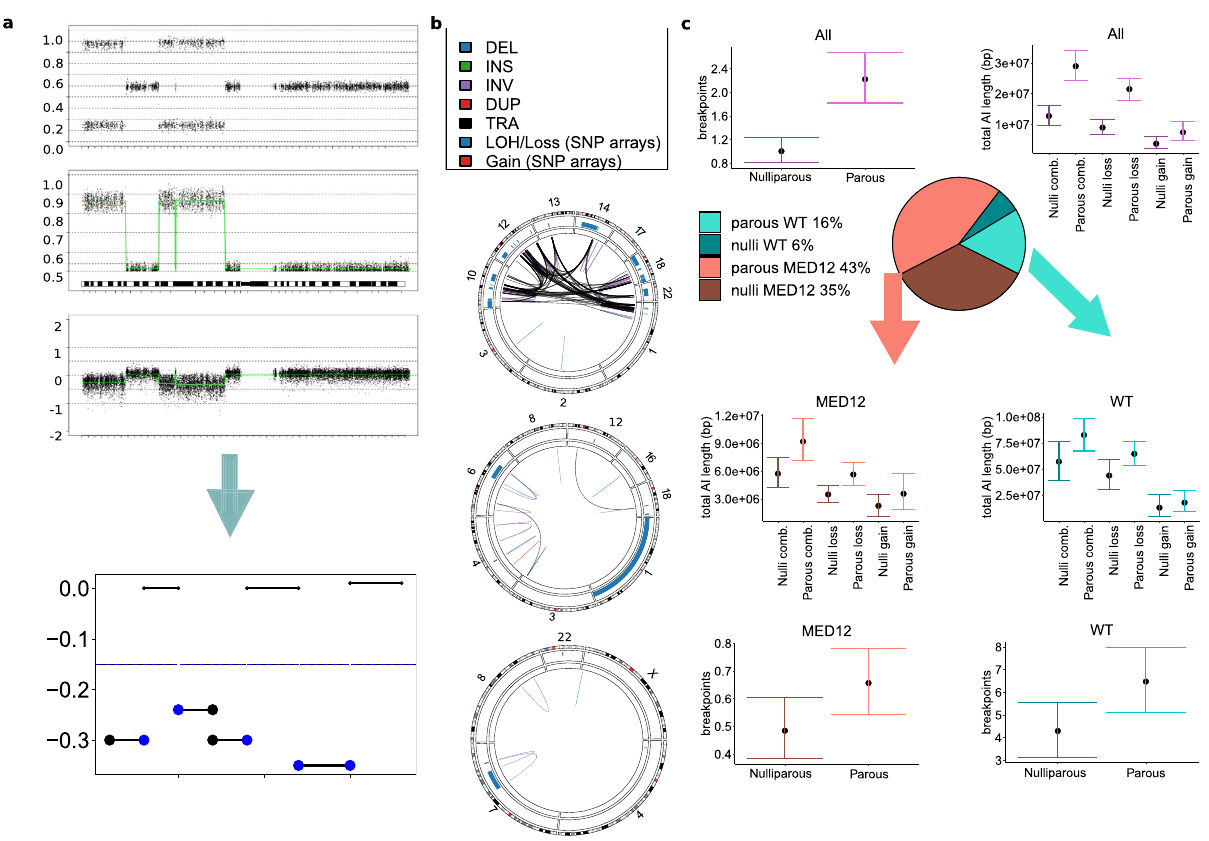
Fig. 2 Overview tumor characteristics. a Allelic imbalance (AI) segments in SNP-array data. From top-down, examples of chromosome 1 B-allele frequencies (BAF), mirrored BAF (mBAF) and Log R Ratios (LRR). Bottom, a schematic fi gure of the interpretation of the segments: black horizontal lines represent AI segments. Blue horizontal line represents LRR threshold − 0.15. Blue dots represent the calculated breakpoints: I. When AI segment is at the end of the chromosome, only one breakpoint is counted for. II. If the LRR difference between adjacent copy-number segments is <0.1, the segments are considered contiguous and are counted as only two breakpoints. III. When the segment is not at the chromosome end and the LRR difference between both adjacent segments is >0.1, two breakpoints are calculated. b Typical allelic imbalance patterns in ULs. Representative examples of complex chromosomal rearrangement (CCR) patterns in different ULs. Only chromosomes affected by allelic imbalance changes are shown: Top: the majority of tumors with high breakpoint count are from tumors wild type (WT) for known MED12 mutations. Translocations between chr12 ( HMGA2 ) and chr14 ( RAD51B ) are common. Middle: chromosomal rearrangements seen in MED12 tumors are typically more moderate. Bottom: whole-chromosome losses were predominantly detected in parous patients ’ WT tumors. Blue line: deletion, green line: insertion, purple line: inversion, red line: duplication, black line: translocation, blue box: LOH/Loss, red box: Gain. c Average breakpoint number, total length of loss regions, total length of gain regions, and the combined length of loss and gain regions are presented for tumors from parous and nulliparous patients. The results are presented for all 1935 tumors (purple) and separately for MED12 (salmon) and WT (turquoise) tumors. 95% bootstrap con fi dence intervals are presented for the mean. In all comparisons, the mean length of tumor genome AI regions is higher in parous than nulliparous patients. Source data are provided. Table 1 Association between chromosomal damage and parity. Response a